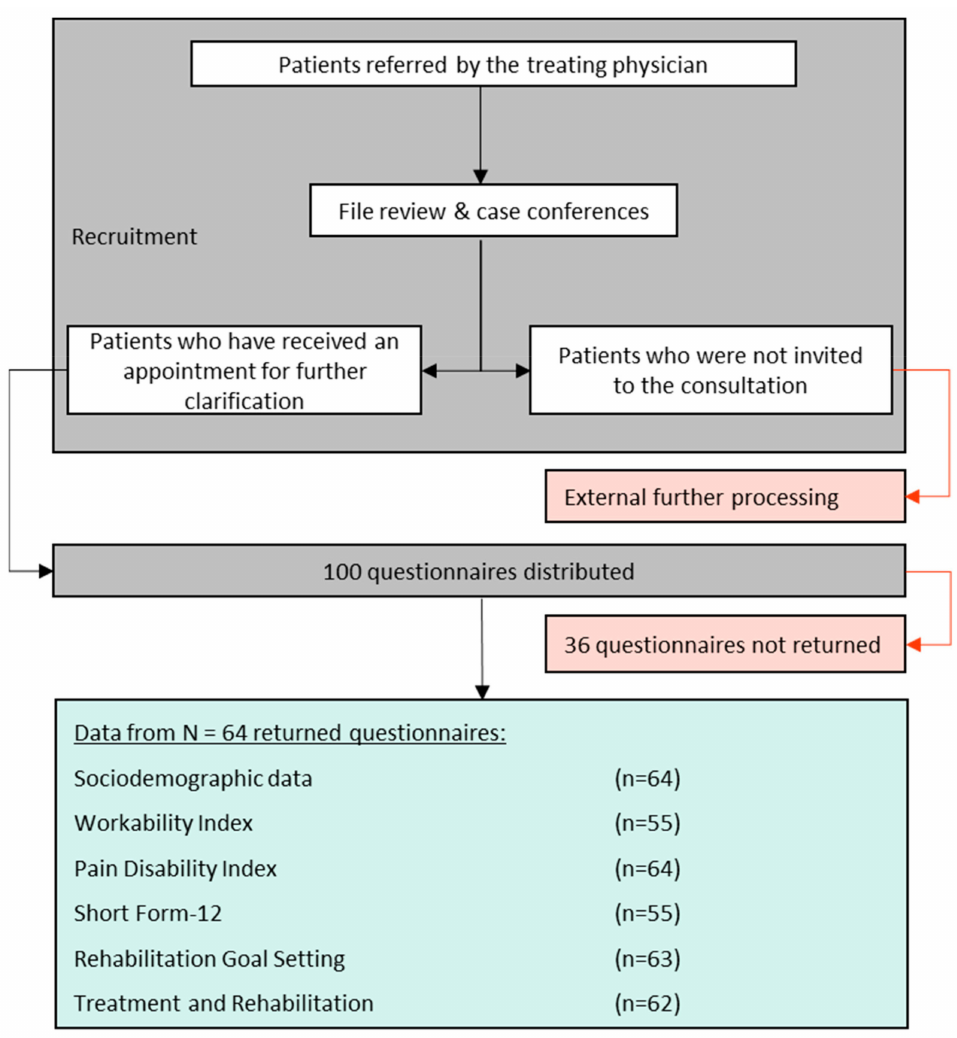
Figure 1. Flow chart of patient recruitment and data